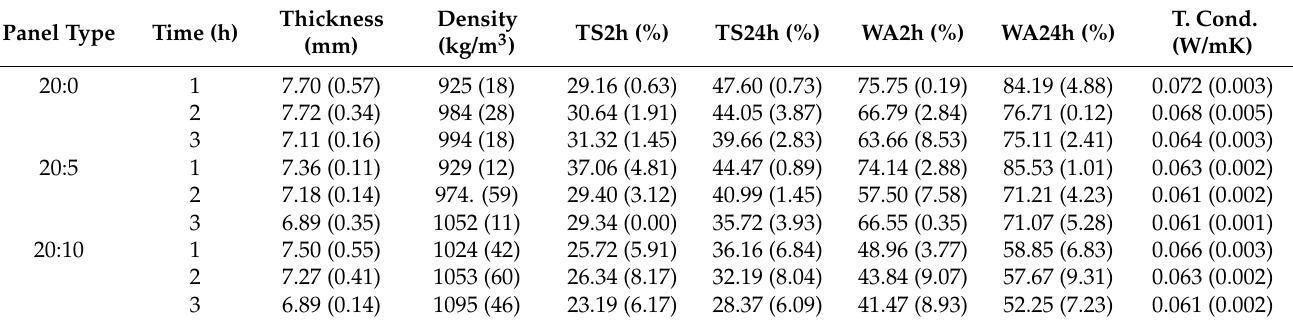
Table 2. Physical properties of the experimental